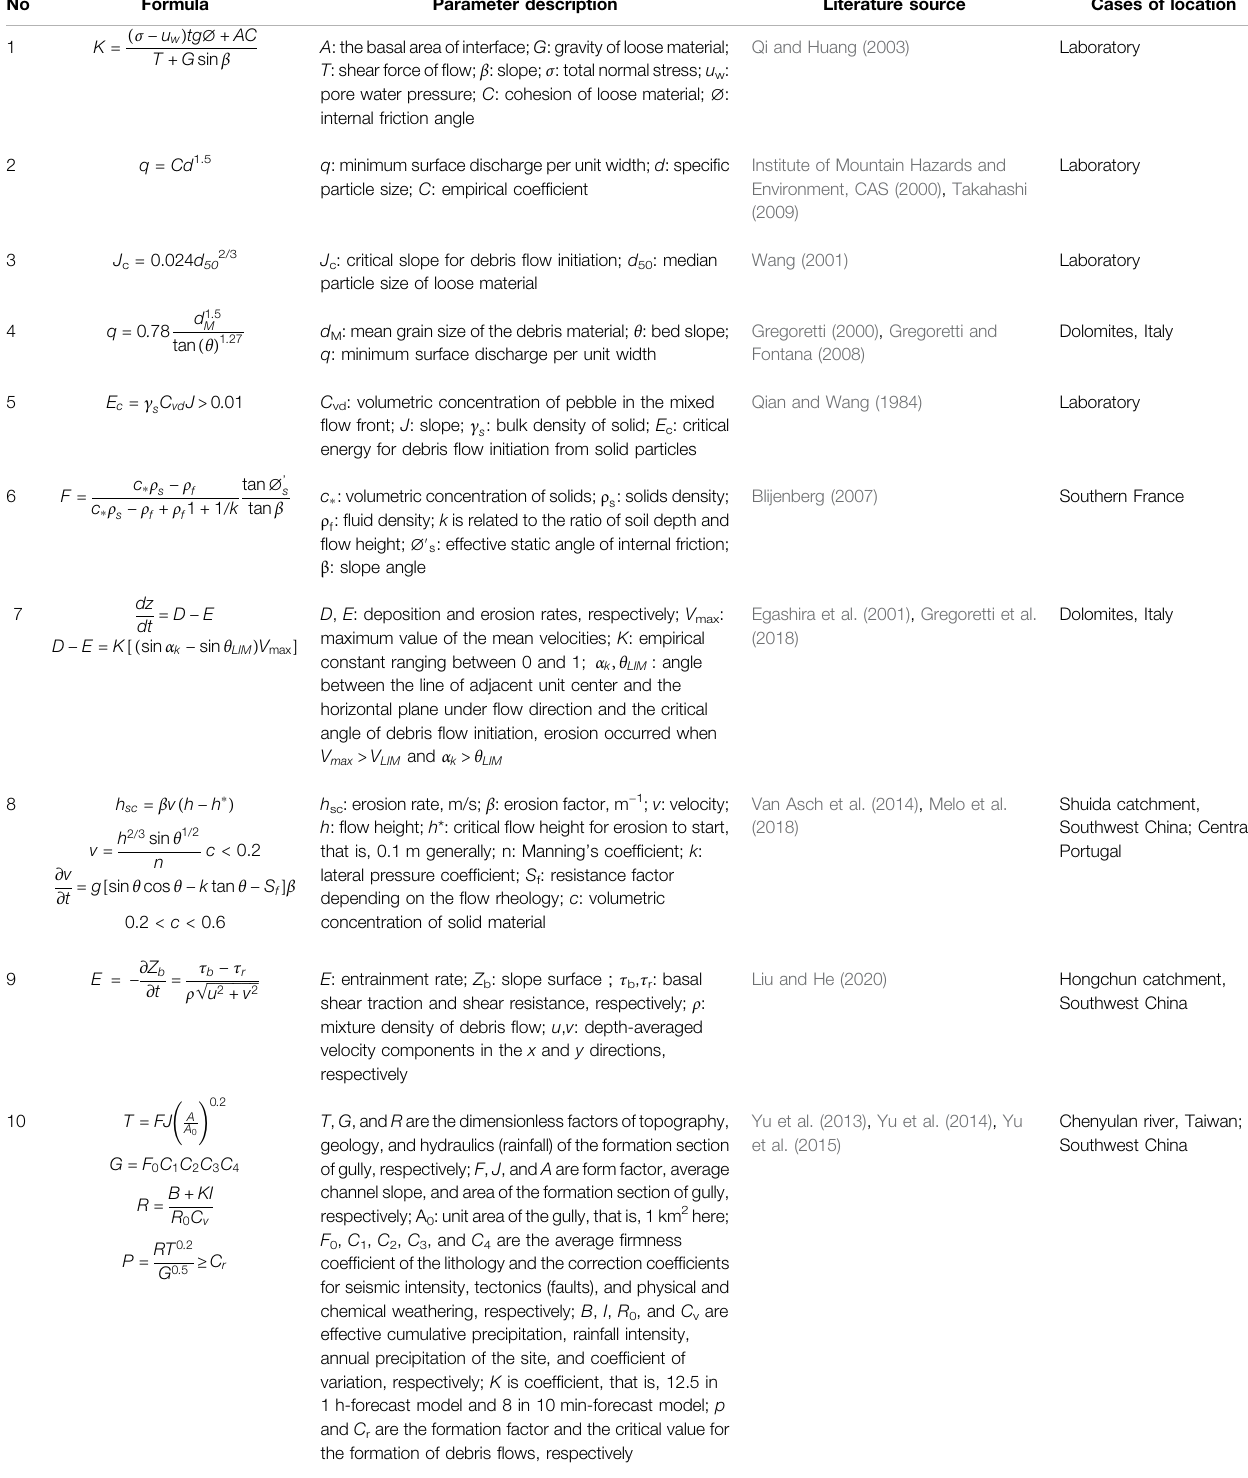
TABLE 1 | Some typical formulas on initial discrimination of debris fl ow and entrainment/erosion rate. No Formula Parameter description Literature source Cases of